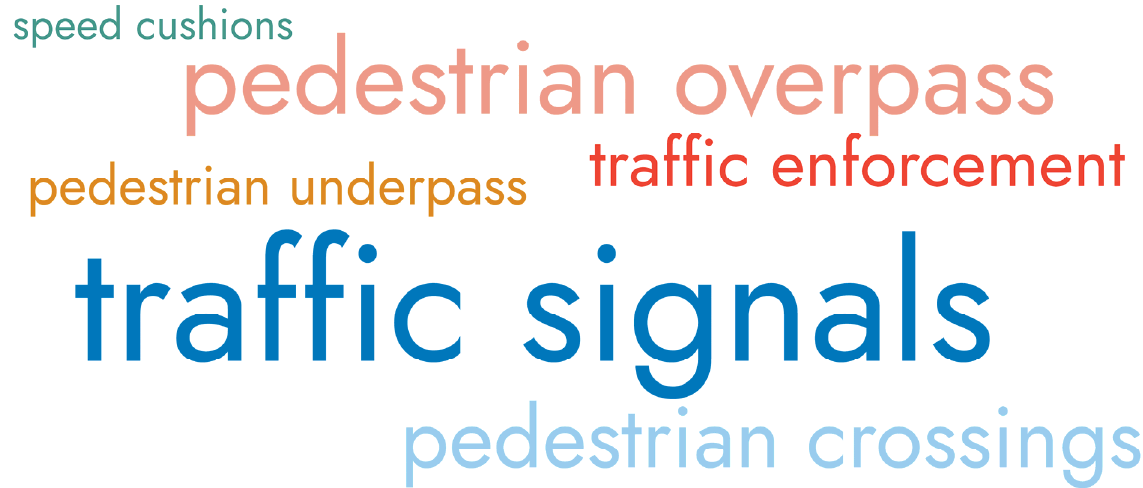
Figure 12. Word cloud illustrating the popularity of six (6) critical mitigating measures.